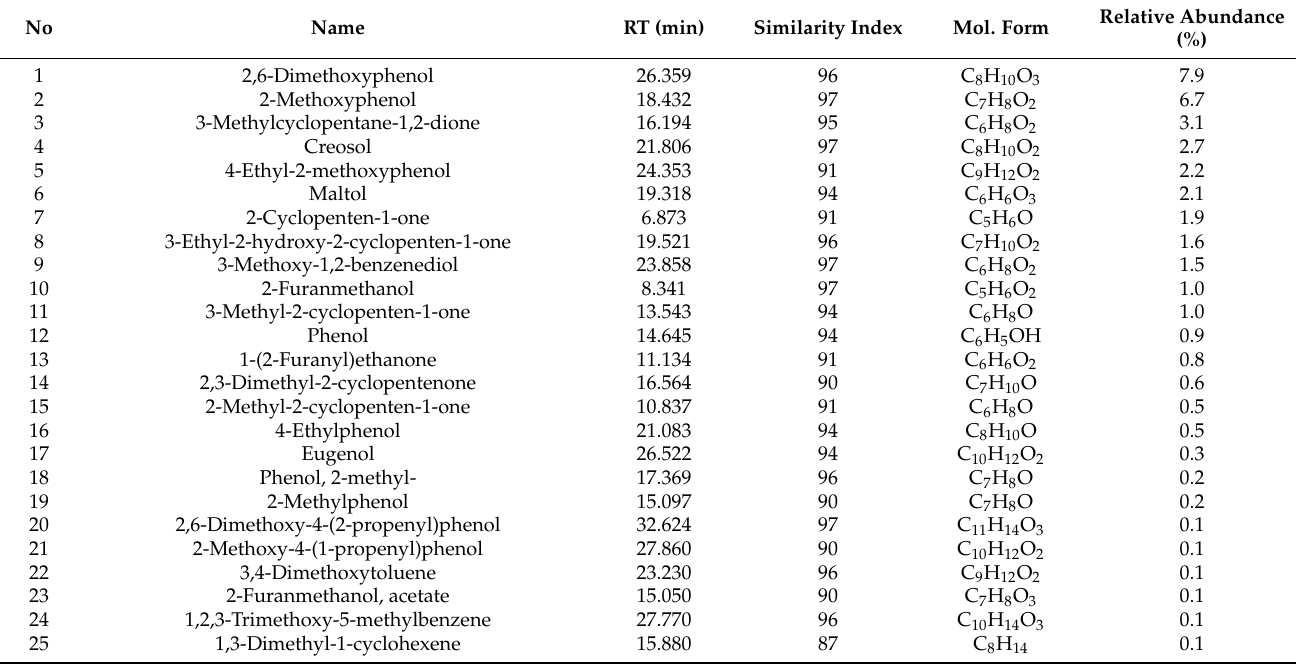
Table 9. Chemical composition of hemp hurds (HR2) distillates from pyrolysis stage (PS) condensed at 70 ◦ C and analyzed by